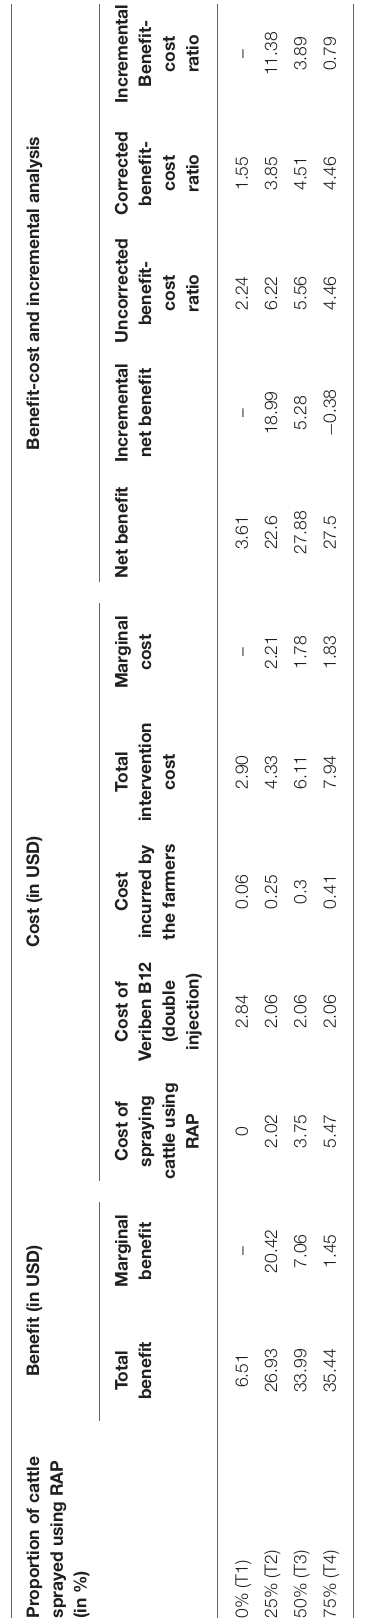
result in farmers focusing on better management of their cattle as well as reducing the occurrence of AAT in other livestock species: equines, sheep, goats, and pigs. In the study area, cattle, sheep, and goats are the only livestock whose productivity is significantly affected by T. vivax and Trypanosoma congolense, with T. brucei having little effect on livestock health. Usually valued at 0.1 tropical livestock units each, the biomass of the small ruminant population recorded for the study households would be about 6% of that of their cattle, which would be reflected in the income they generated. It is likely that there were some benefits to small ruminant health via reduced exposure to tsetse fly bites, although, as discussed below, tsetse feed preferentially on larger animals. Similarly, reducing tsetse and tick populations will benefit non-participating livestock of households. Spillover benefits for human health from RAP, by reducing transmission of zoonotic rHAT were outside the scope of this study. However, the One Health implications of treating cattle with trypanocides and RAP and impact on rHAT have been described and modeled previously (27, 32, 43). Mass chemoprophylaxis and RAP applied to 500,000 cattle between 2006 and 2008 was accompanied by a reduction of 75% in the animal trypanosome prevalence, accompanied by a 90% reduction in reported rHAT cases (43). Additionally, administration of a single dose of diminazene aceturate by the Stamp out Sleeping Sickness public-private partnership in 2008 in districts to the north of Tororo saw